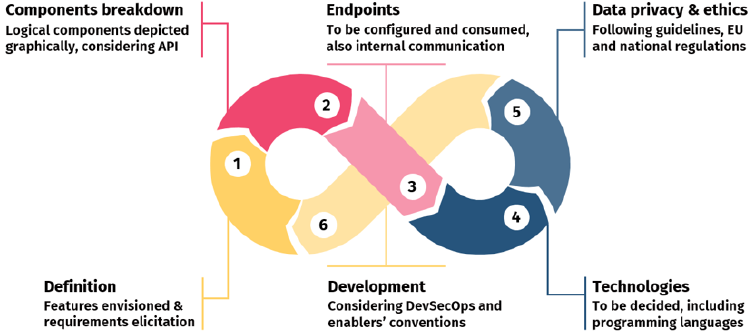
Figure 7. ASSIST-IoT development view—development process